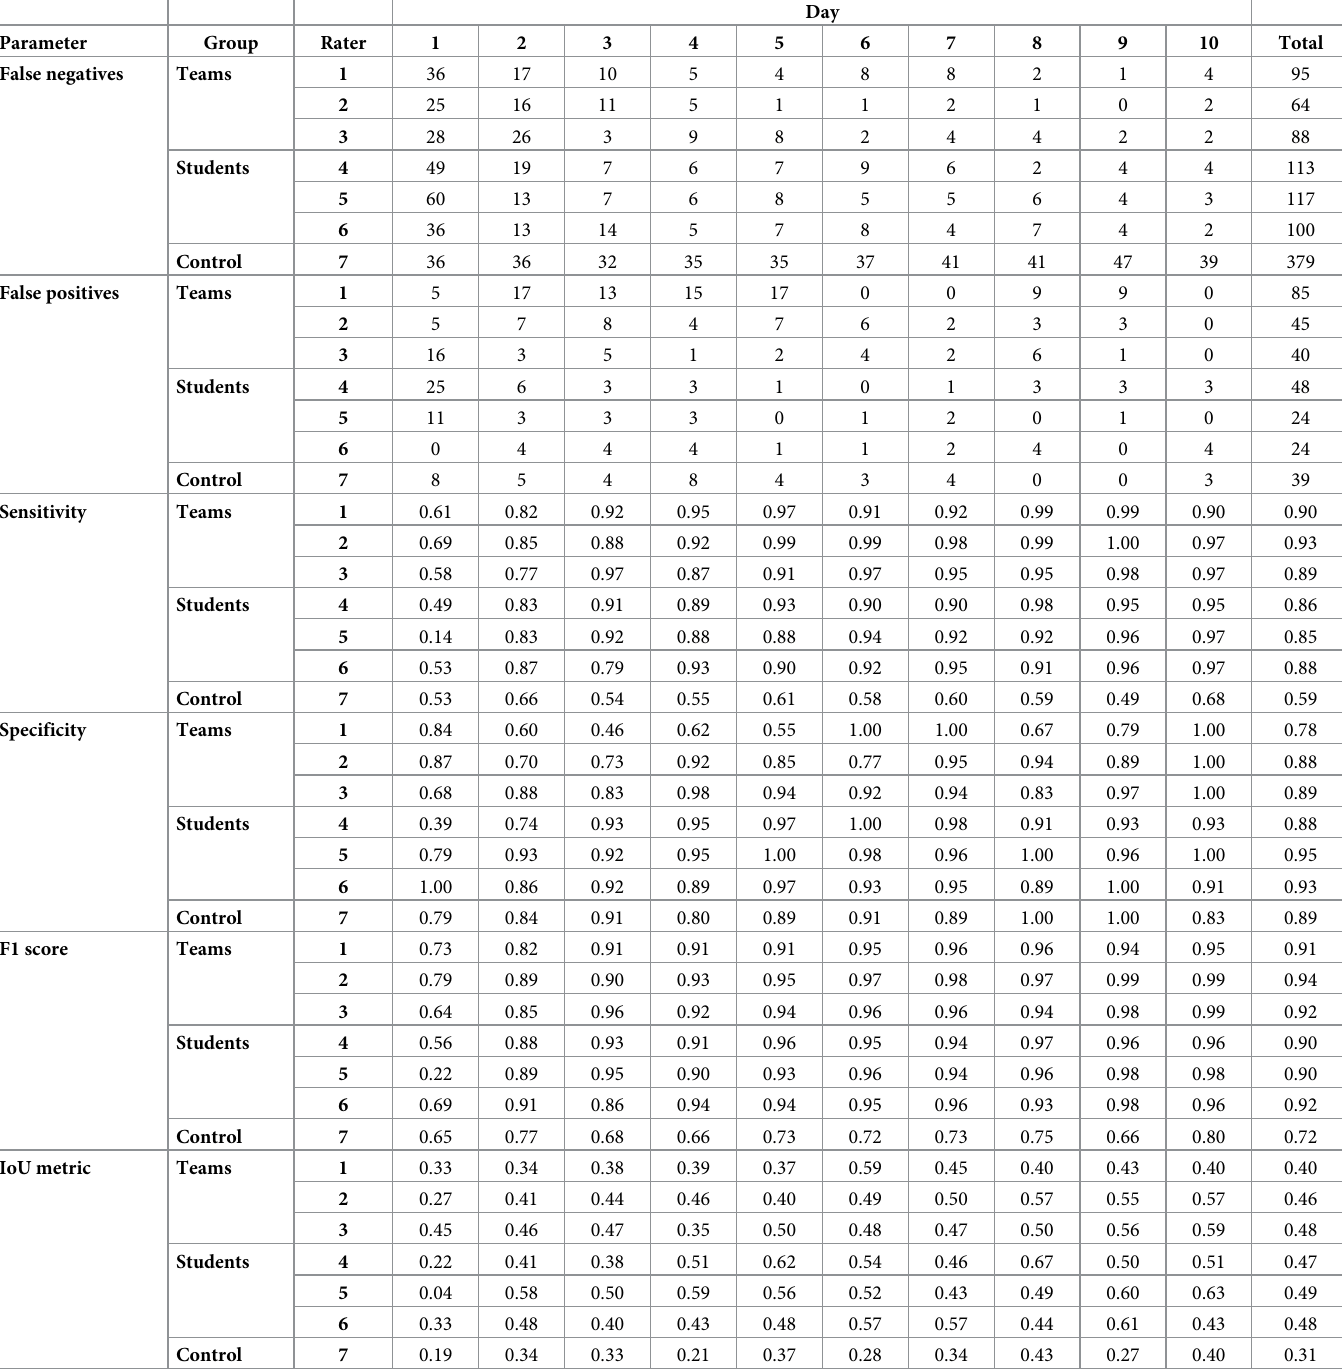
Table 2. Summary of fundamental parameters across all ten days and in total, split into the seven raters. Sums are shown for false negatives and false positives, mean values for sensitivity, specificity, and F 1 score, and mean values plus SD for